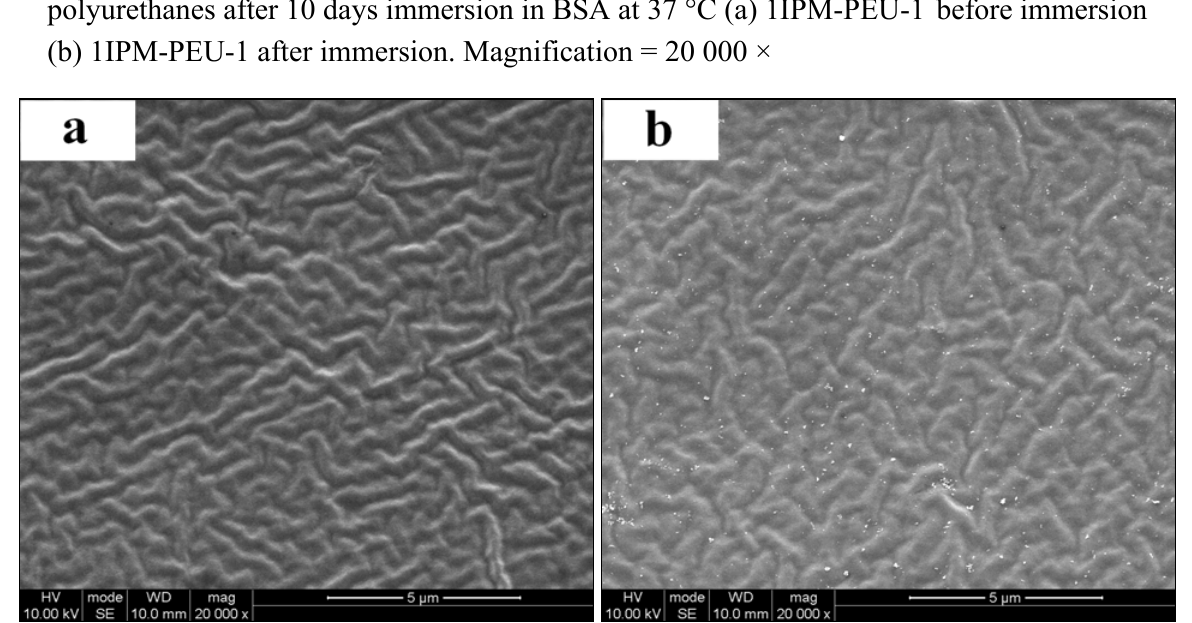
Figure 4. Scanning electron micrograph (SEM) showing surface of IPM modified polyurethanes after 10 days immersion in BSA at 37 °C (a) 1IPM-PEU-1 before